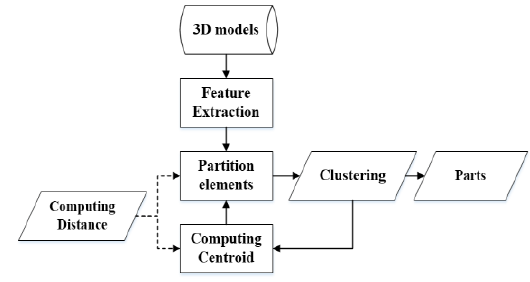
Figure 3. K-means++ algorithm process